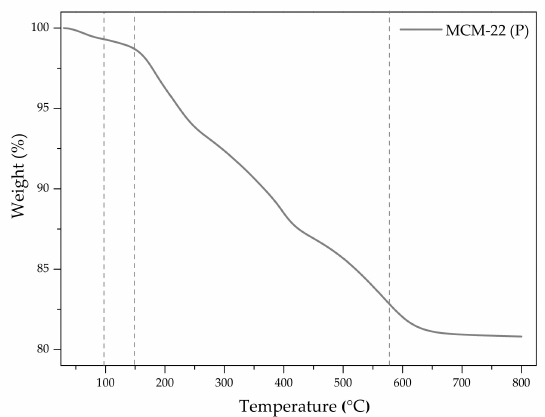
Figure 8. TGA profile of the precursor MCM-22 (P) obtained in the temperature range of 30–800 ◦